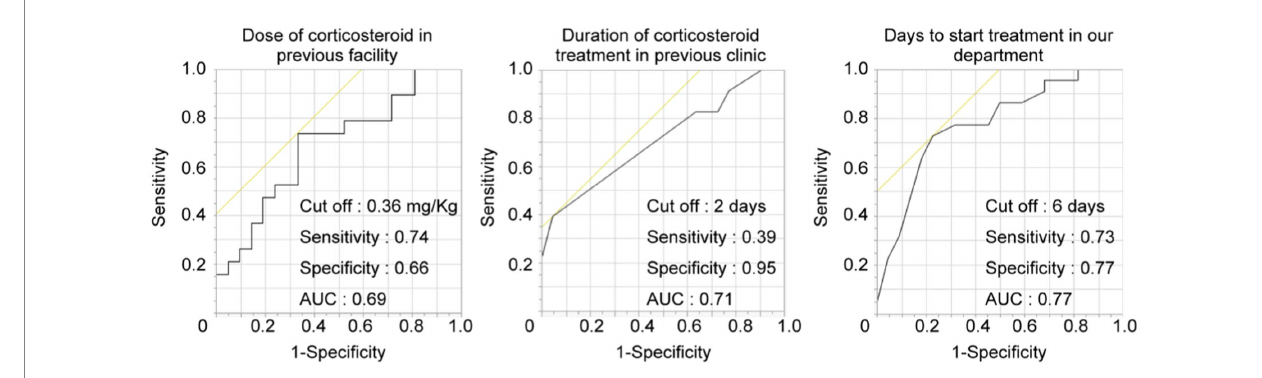
FIGURE 2 Cut-off value of prognostic factors in the repetitive-treatment group. ROC curve to predict the hearing prognosis according to corticosteroid dose, duration, and days to start treatment. The AUCs were 0.69, 0.71, and 0.77, respectively. AUC, area under the